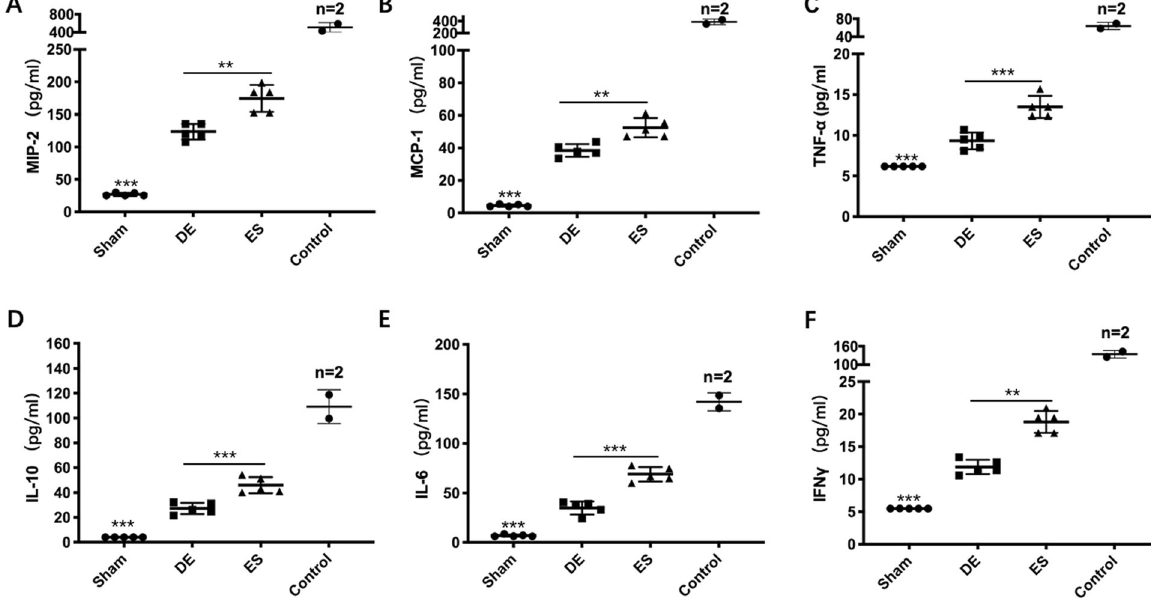
Fig. 3 De-escalation strategy allays in fl ammatory response in the late sepsis stage. A – F . The serum levels of MIP-2, MCP-1, TNF- α , IL-10, IL- 6, and IFN- γ were measured using Luminex ® xMAP ( n = 17). The in fl ammatory cytokines levels were lower in the DE group than that in the ES group ( p < 0.01), which was coincident with that in the early sepsis stage. And in the control group ( n = 5), those biomarkers were extremely higher than those in antibiotic groups. DE de-escalation. ES escalation.